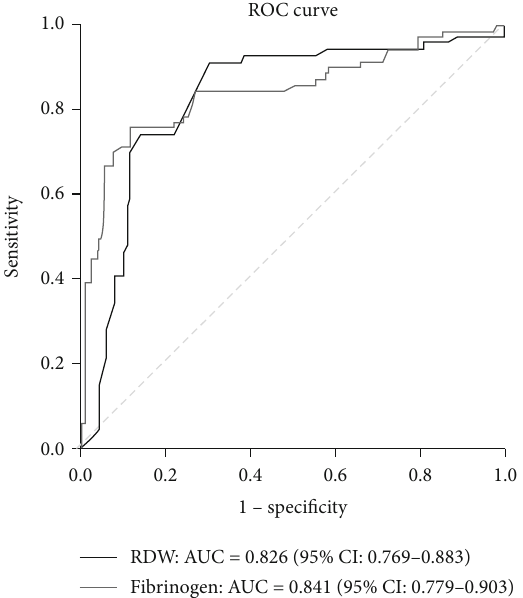
Figure 3: ROC analysis for RDW and fi brinogen associated with ACS. Fibrinogen ( AUC = 0 : 841 , 95% CI: 0.779-0.903) and RDW ( AUC = 0 : 826 , 95% CI: 0.769-0.883) were strong predictors for ACS through the ROC